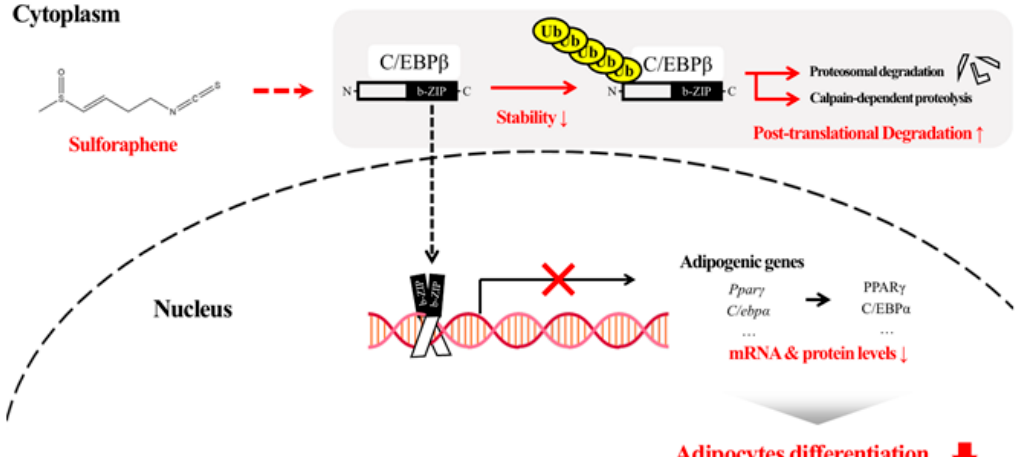
Figure 7. Diagram of the proposed mode of action of sulforaphene (SFEN) in adipogenesis. C / EBP β is involved in the mechanism underlying the inhibitory effect of SFEN. SFEN decreases the levels of C/EBP β through post-translational degradation via proteasome-dependent and calpain-dependent pathways.